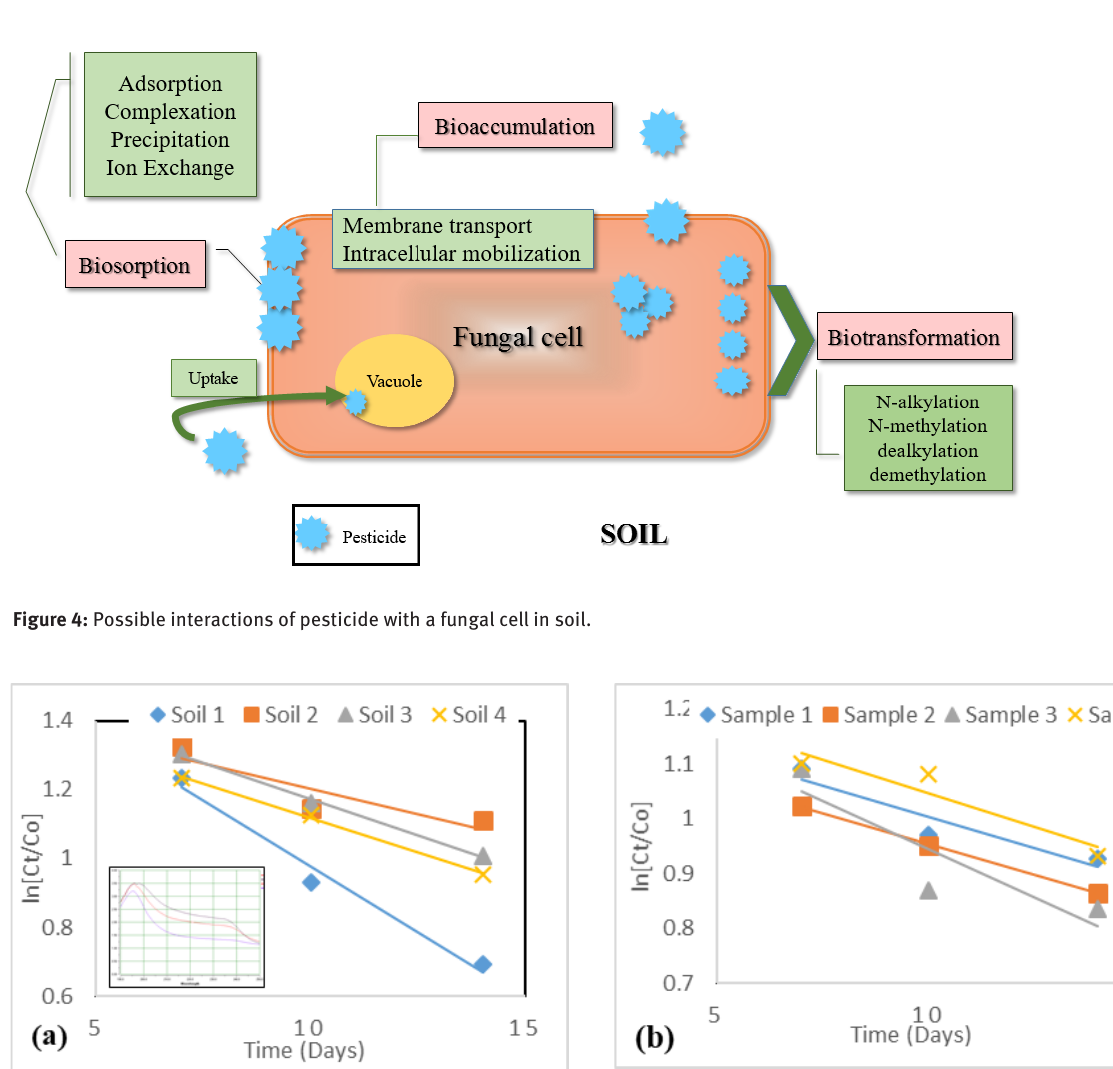
Figure 5: Linear plots of log of concentration of Bensulfuron-methyl hydrolysis with time (days). (a) Hydrolysis in soil samples. (b) Hydrolysis in water with pH corresponding to that of soil samples.